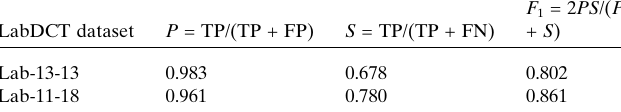
Table 3 Performance of grain